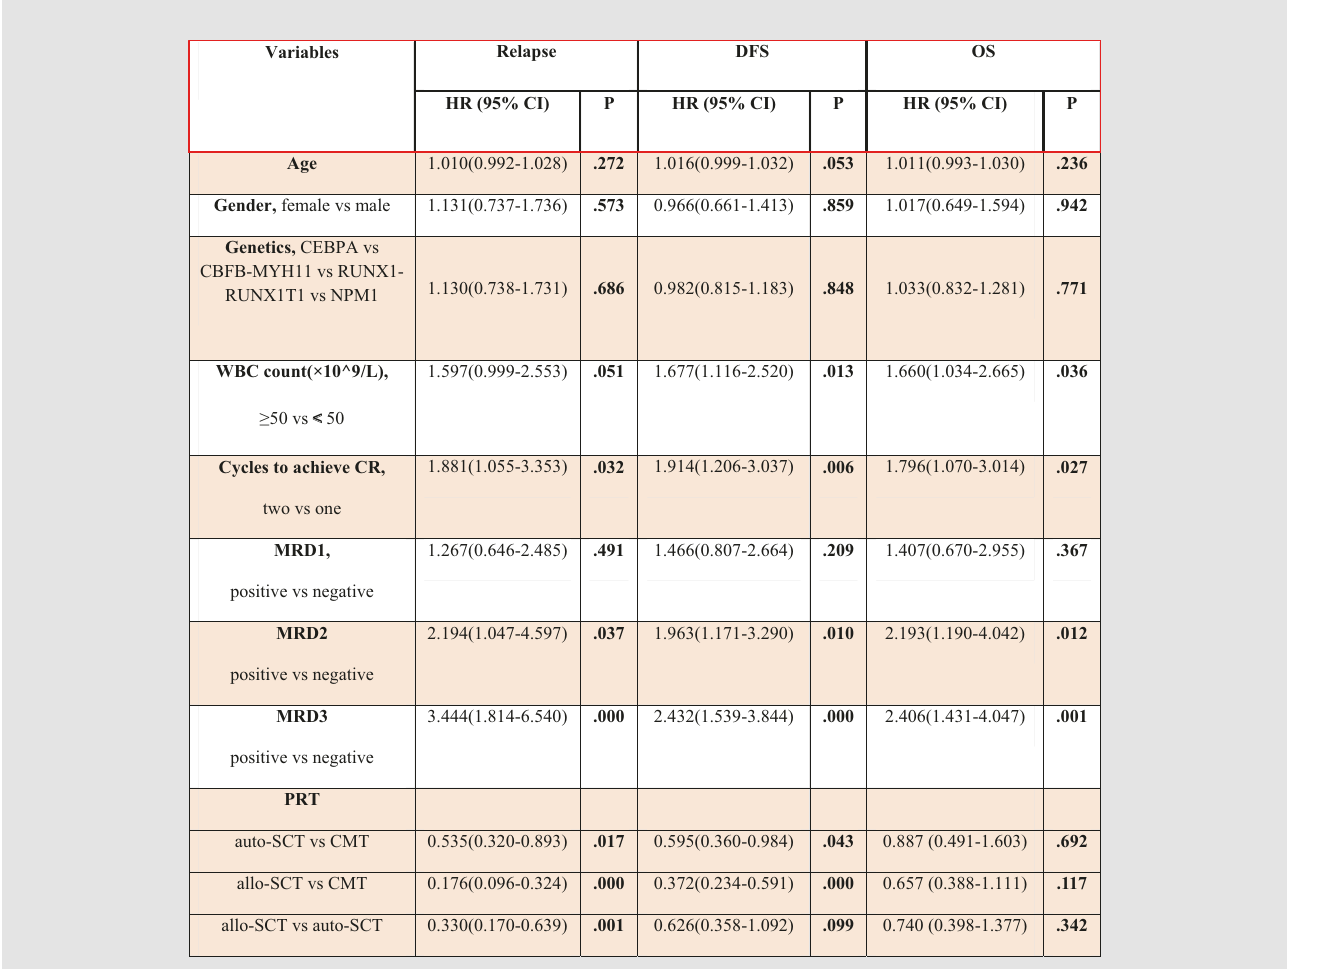
Table 2. Multivariate analysis for relapse, DFS, and OS.